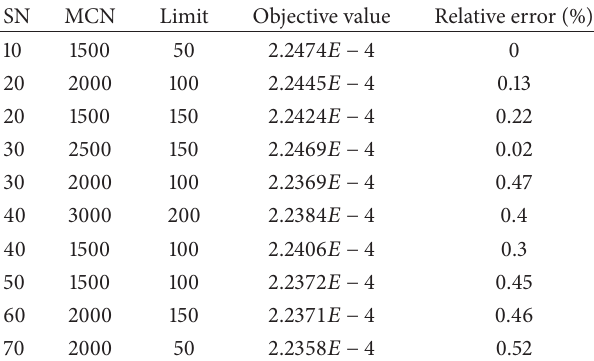
Table 4: Robustness analysis for the modified ABC algorithm (𝑢 0 = = 1.8) . 0.08 , ℎ 0